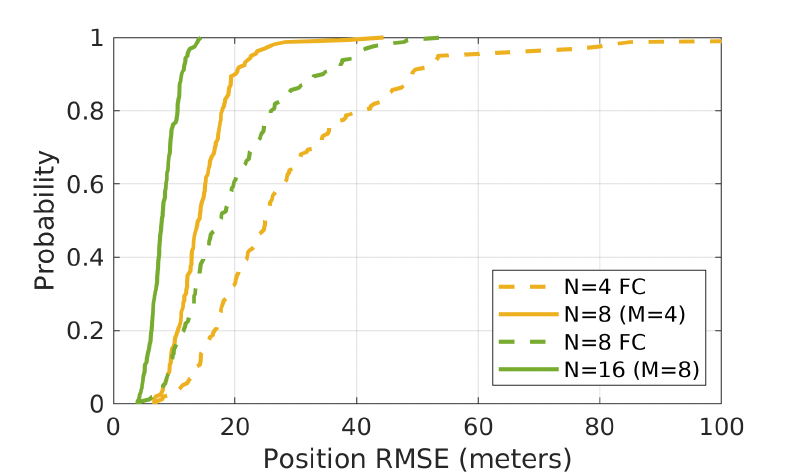
Figure 7. The CDF of each simulation’s average position error for all agents in the group for 160 Monte Carlo simulations with different algorithms and group sizes. These simulations are run with the bathymetric map shown in Figure 5.